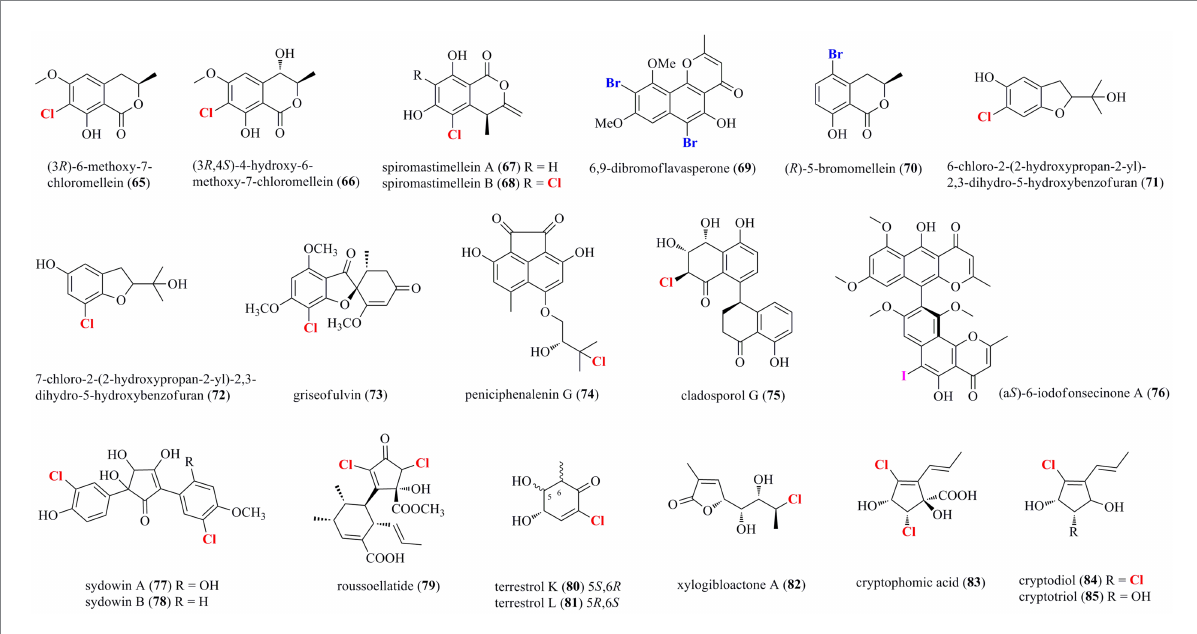
FIGURE 4 Halogenated coumarin − /chromone/pyran − /furan-derived polyketides from marine-derived fungi ( 65–85 ).